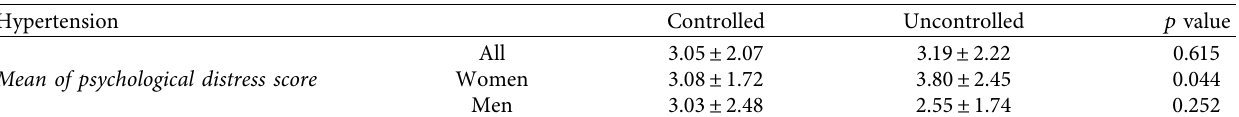
Table 2: The mean of psychological distress score in people with controlled and uncontrolled hypertension. A p value < 0.05 was considered significant.